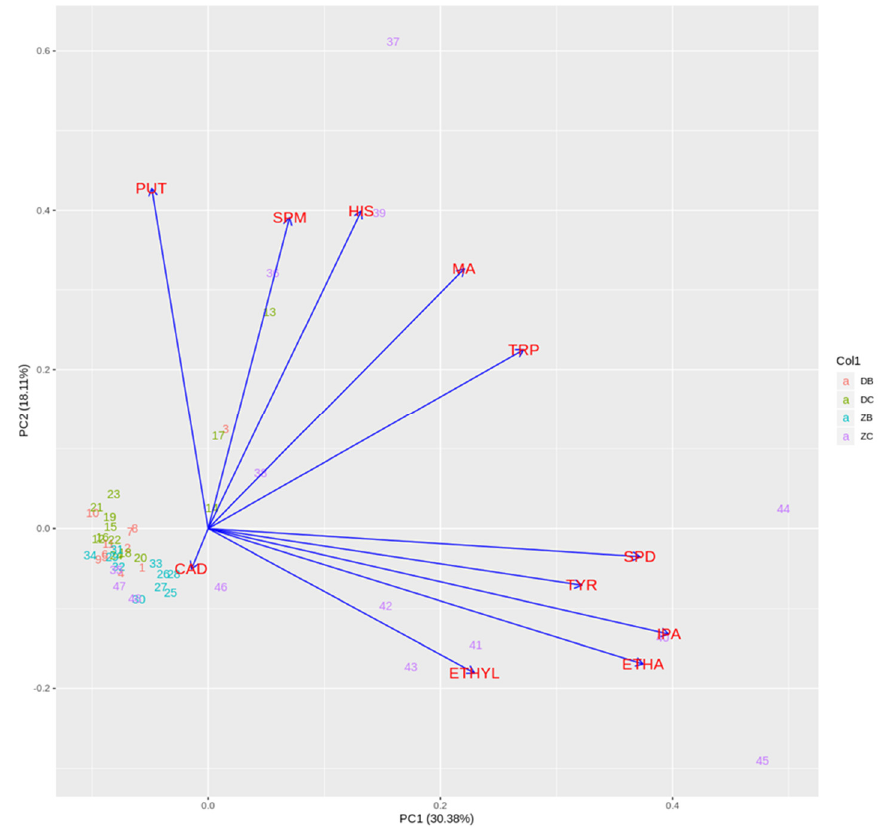
Figure 2. PCA plot. Table 4 contains abbreviations for biogenic amines. Numbers correspond to samples’ in Tables 1 and 2. DB = Dalmatian white samples, DC = Dalmatian red samples, ZB = Hrvatsko zagorje white samples and ZC = Hrvatsko zagorje red samples.